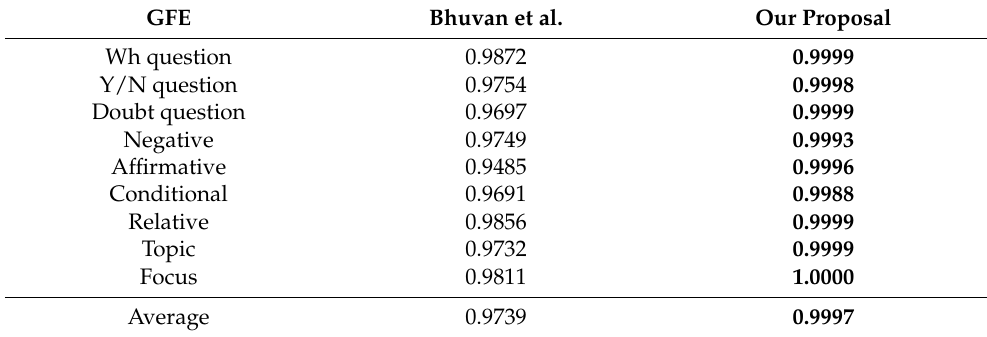
Table 5. ROC-AUC scores achieved by our proposed model and other state-of-art approaches using a dataset storing grammatical facial expressions of the Brazilian sign language (Libras) made by subject two. Best results are in bold.